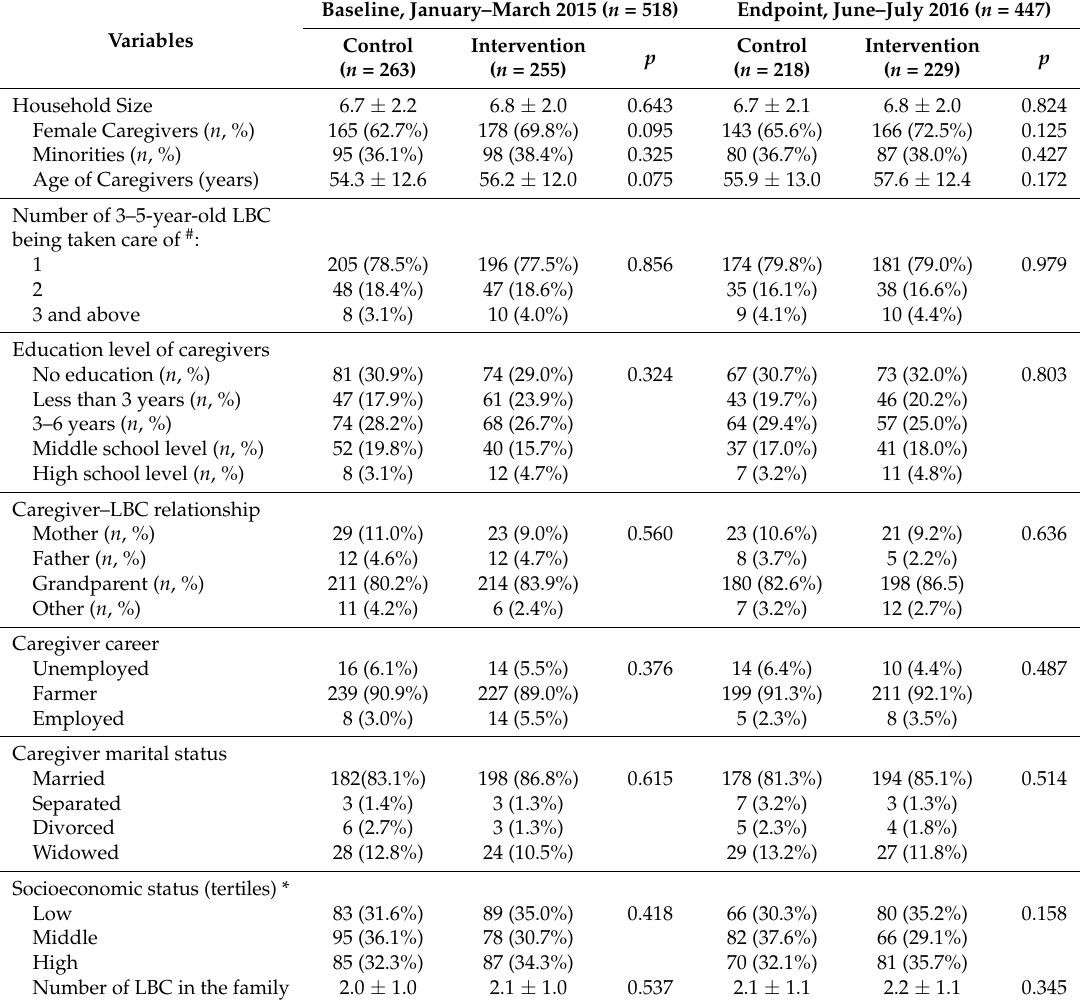
Table 1. General characteristics of caregivers of left-behind children (CLBC) and households at baseline and the